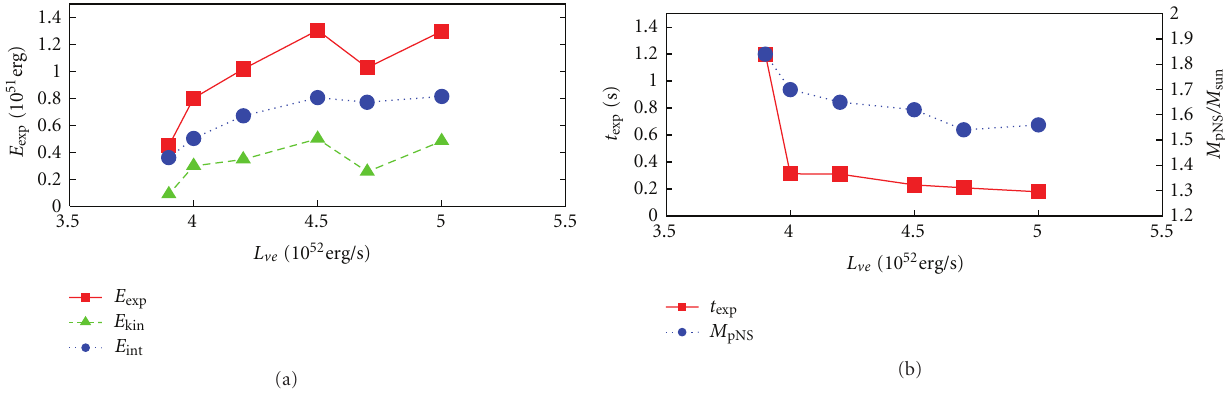
Figure 14: Panel (a) shows explosion energies (red line) versus input neutrino luminosities ( L ν e ), where green and blue lines show contributions from kinetic and thermal energy, respectively. Panel (b) shows the mass of protoneutron star ( M PNS ) and the explosion timescales ( t exp ) as a function of L ν e . M PNS is estimated as the enclosed mass exceeding 10 12 gcm − 3 and t exp as the time scale when the mass ejection rate at 100 km drops down to 0 . 1 M (cid:3) / s in our 2D simulations (from [248]).